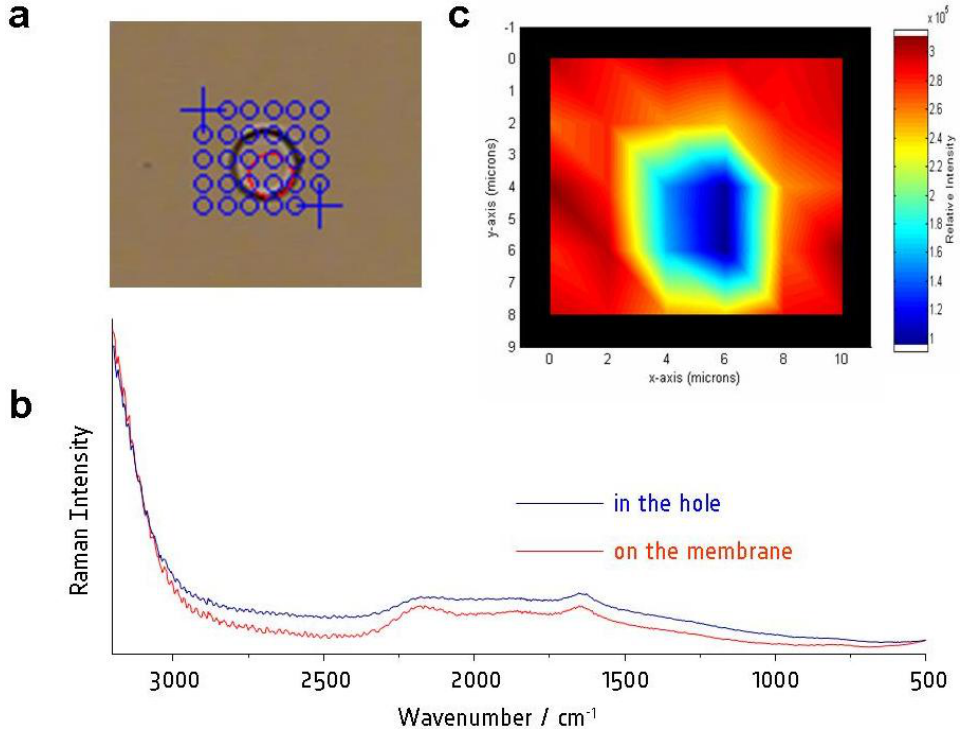
Figure 2. ( a ) White light image of empty microhole and grid used for Raman mapping; ( b ) Representative Raman spectra from different positions on the chip: over an empty hole and on the Si N membrane; ( c ) False color Raman map depicting the intensity distribution 3 4 of the H –Si–N stretching vibration around 2180 cm −1 x x